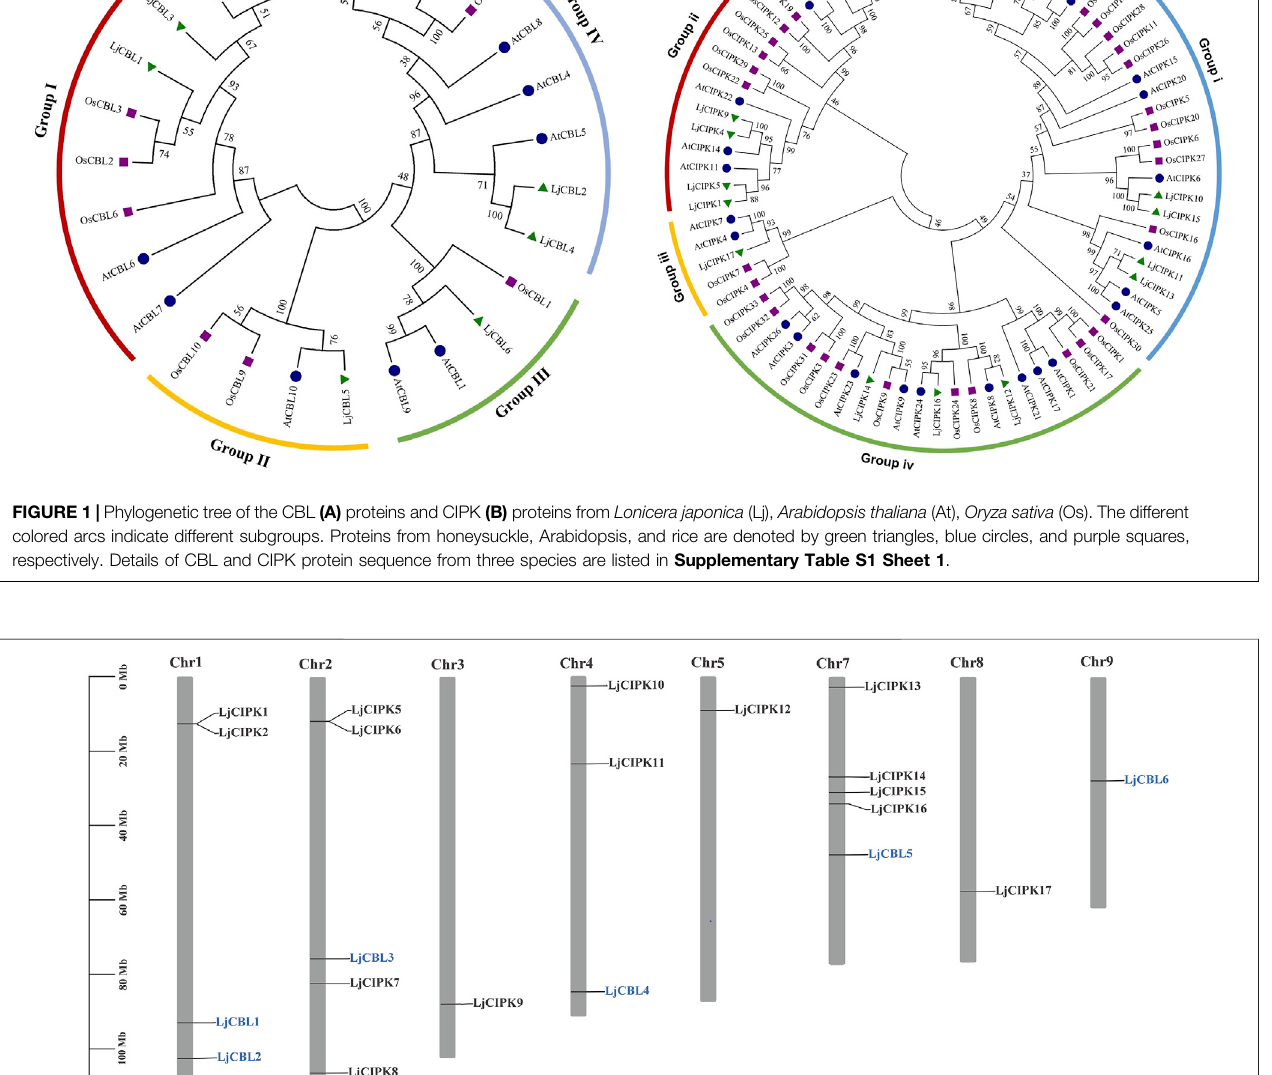
Frontiers in Genetics |